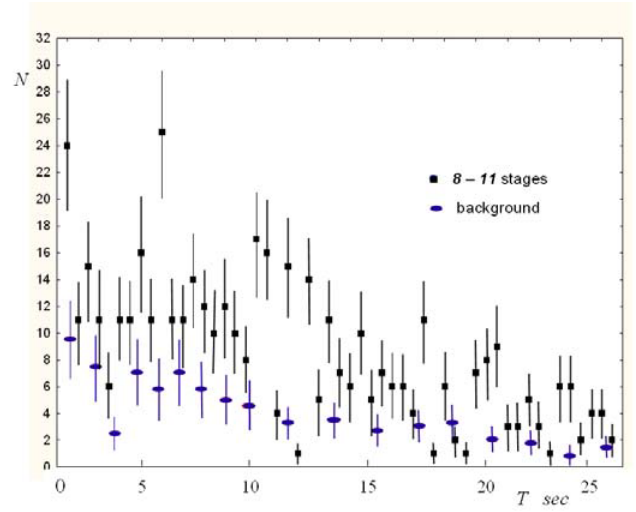
Figure 2. T distributions for fish eggs at 8 ÷ 11 stages - full squares and detected background - full